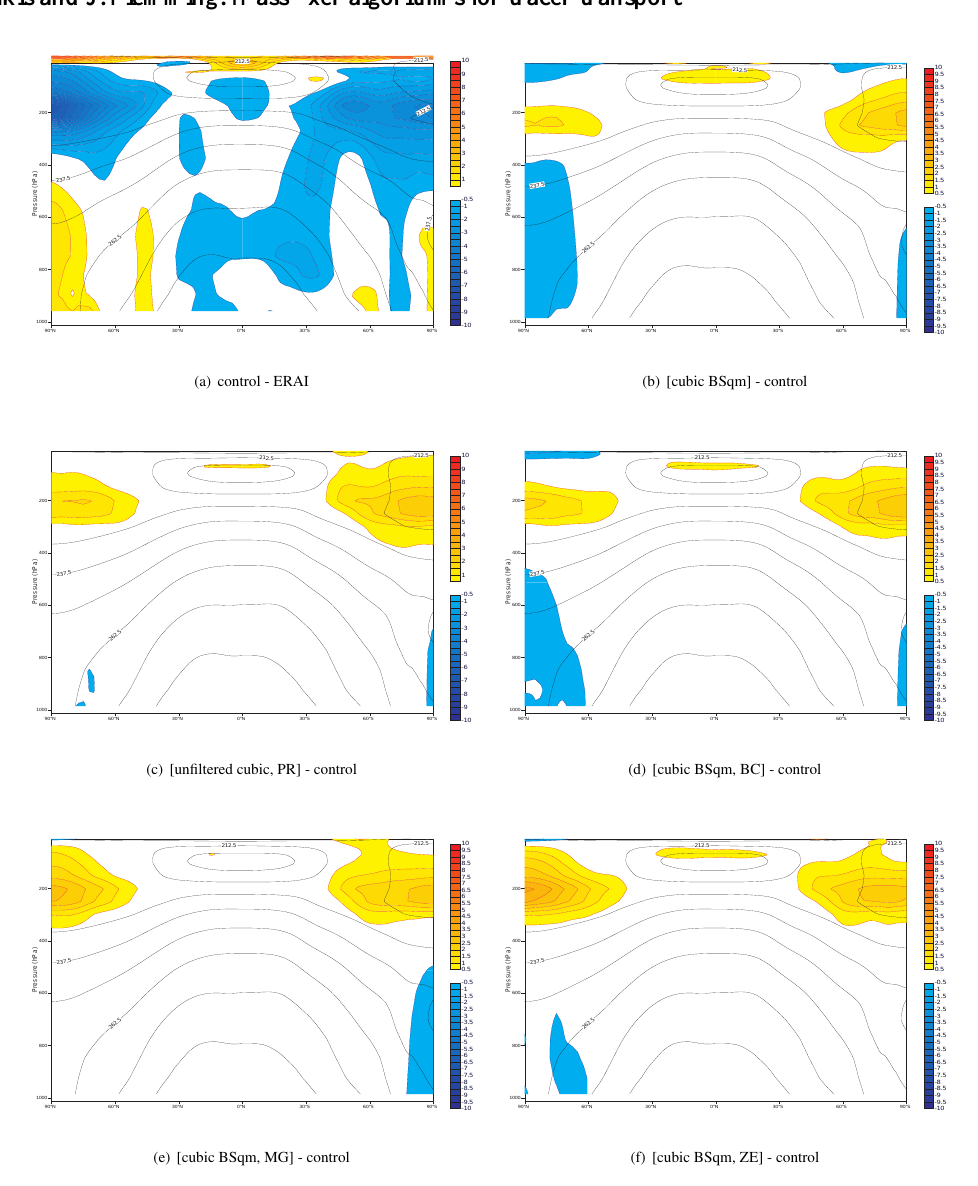
Figure 6. Experiments with the BS limiter described in Table 1. Difference of vertical cross sections of zonally averaged annual mean tem- Fig. 6. Experiments with BS limiter described in Table 1. Difference of vertical cross-sections of zonally perature fields. (a) : difference (in Kelvin) between control forecast and the ERA-Interim. (b–f) : difference (in Kelvin) between experiments averagedannualmeantemperaturefields. Plot(a): difference(inKelvin)ofcontrolforecastfromERA-Interim. and control Plots (b-f): difference (in Kelvin) of experiments from control forecast.